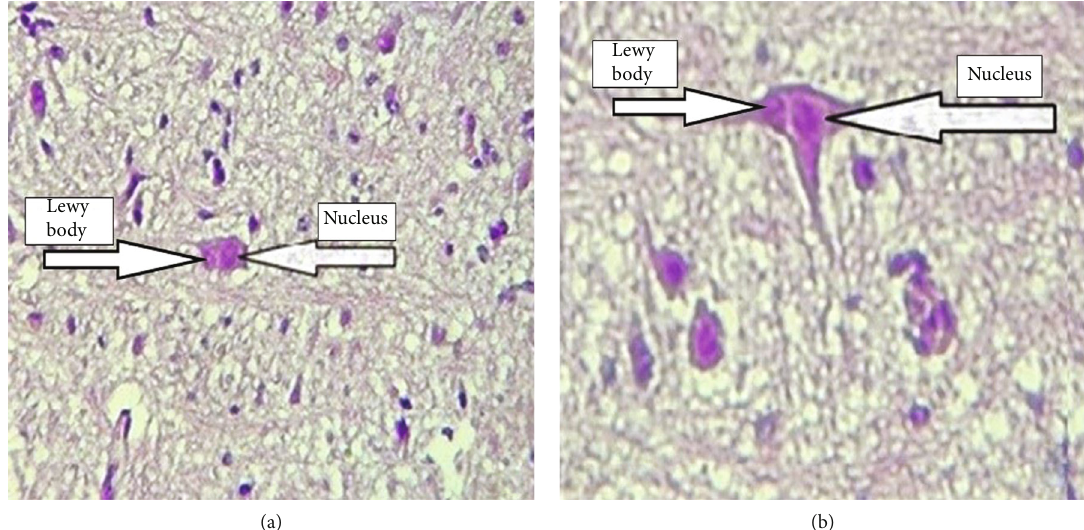
Figure 3: The presence of Lewy bodies in mouse brains (H&E): (a) 10x and (b) 40x.